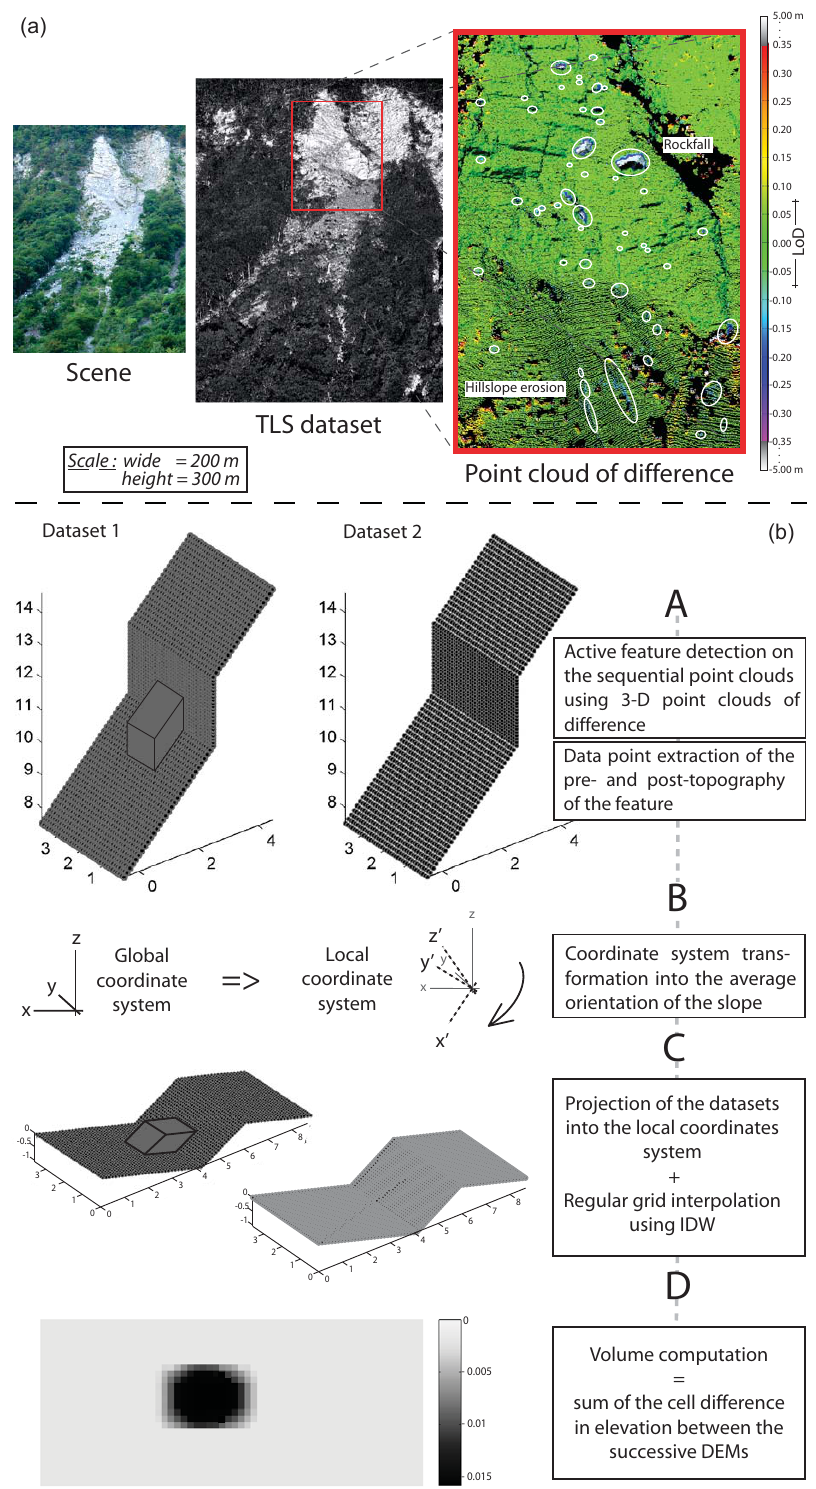
Figure 5. 3-D detection (a) and schematic illustration (b) of the extraction and volume computation method of an individual active feature provided by two successive point cloud